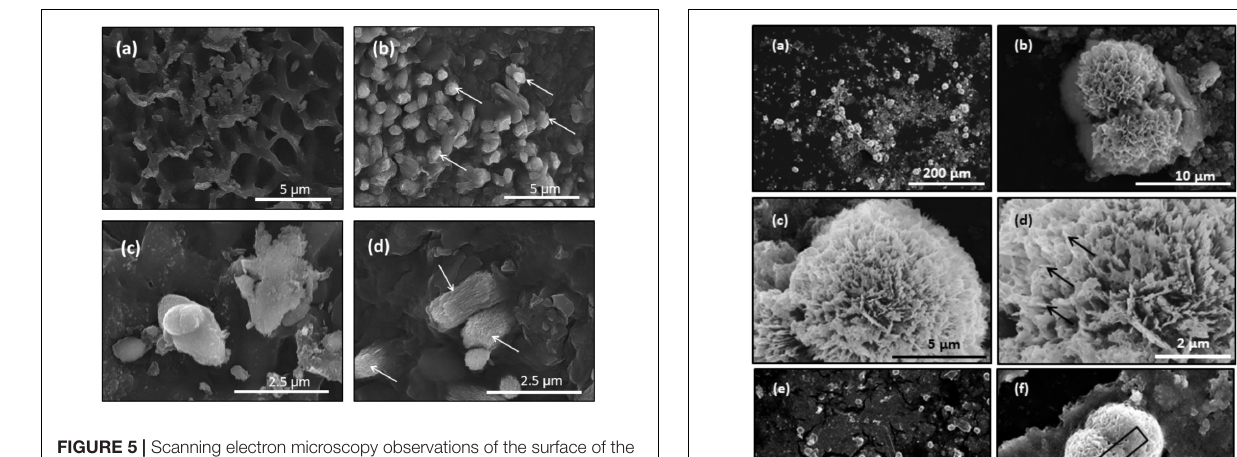
FIGURE 5 | Scanning electron microscopy observations of the surface of the growing edge of the ligament after crystallization. (a,c) hrMMP-13 treatment and (b,d) no MMP treatment (decalcification only). (a,b) Low magnification; (c,d) high magnification. The treatment of hrMMP-13 inhibited the calcification of the decalcified ligament. White arrows indicate the aragonite crystals.